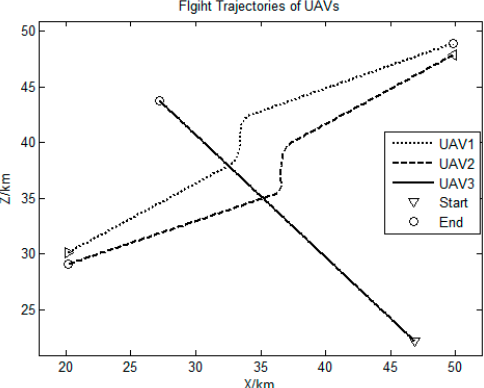
Figure 9. Fight trajectories of 3 UAVs.